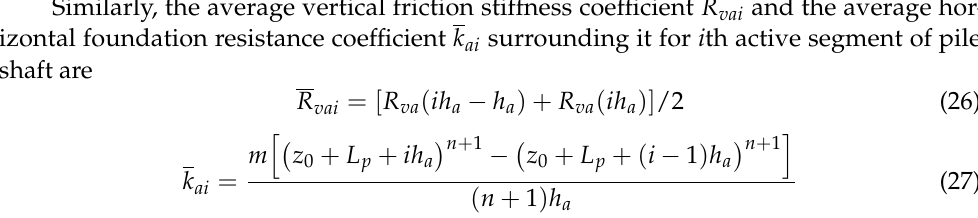
where the notations of a indicate the active segment for the pile shaft. shaft can be formulated as (Appendix C).